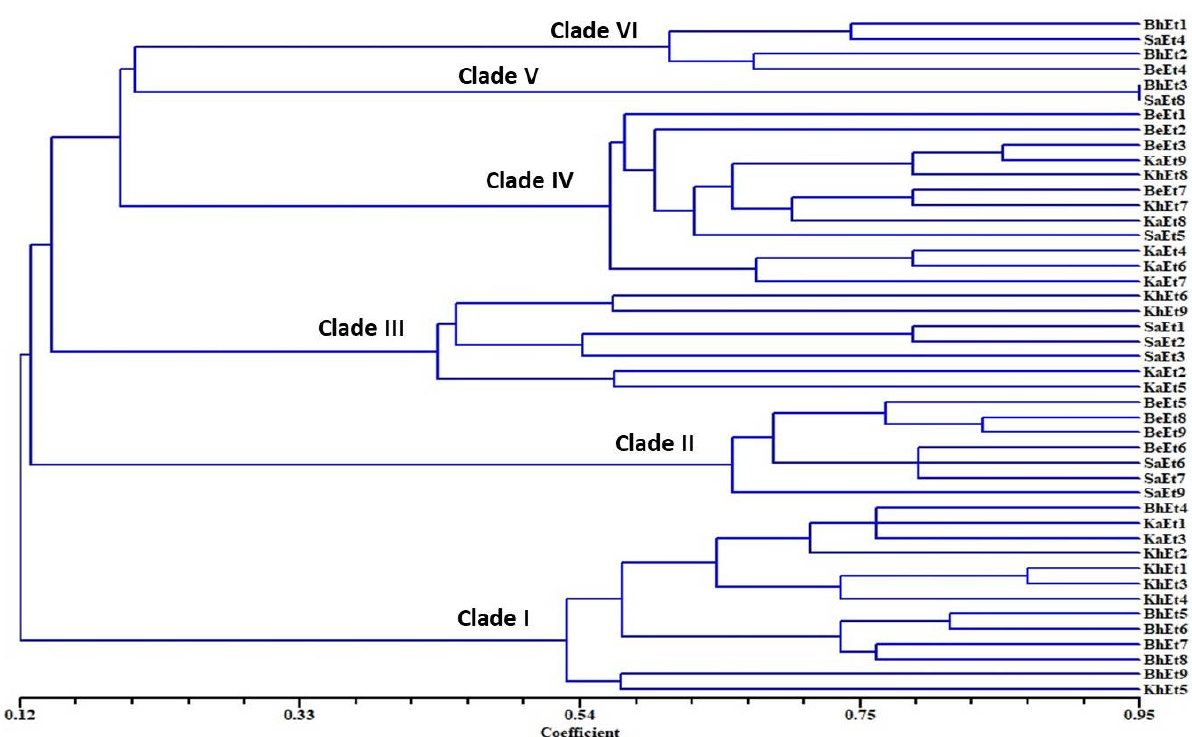
Figure 4. Dendrogram on the basis of morphological and cultural variability of 45 E. turcicum isolates causing NCLB disease.